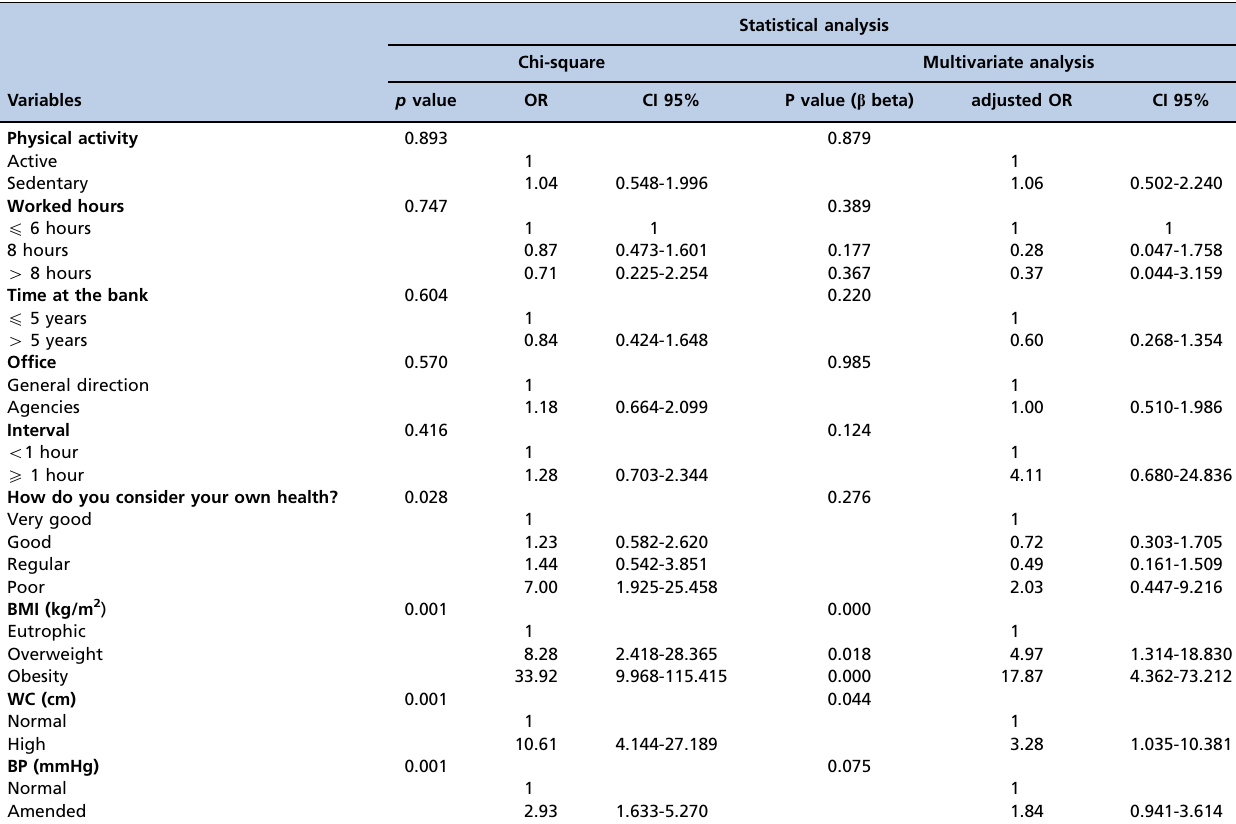
Table 3 - Regression results, gross and adjusted for insulin resistance, Vito´ria/ES-Brazil.